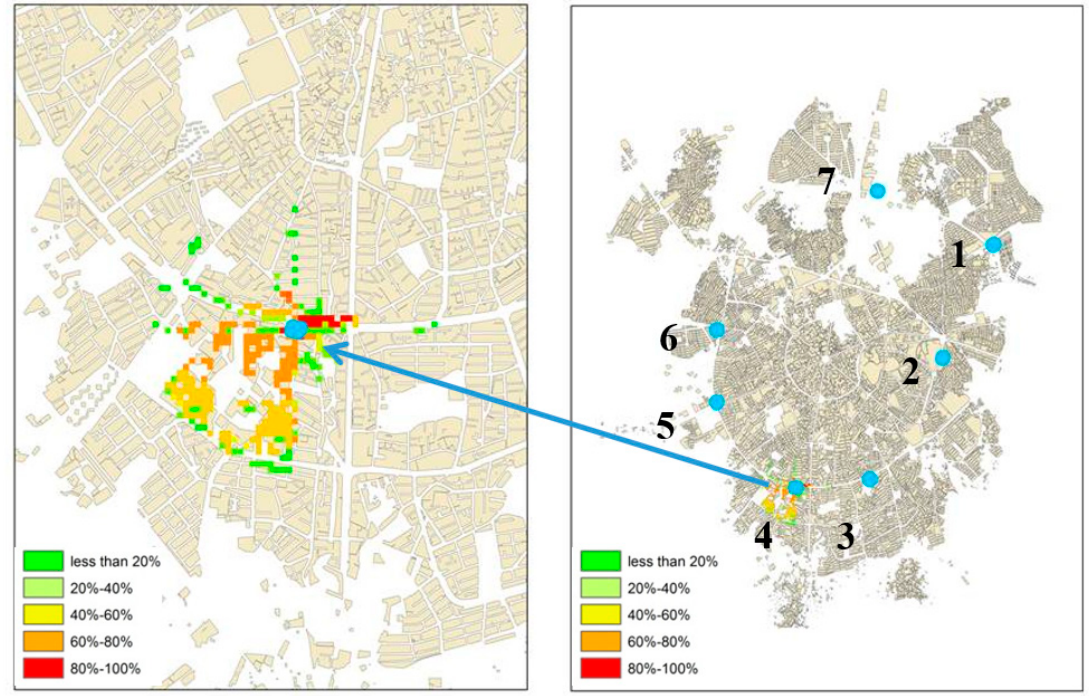
Figure 25. Visibility map of hypothetical tall building No. 4.